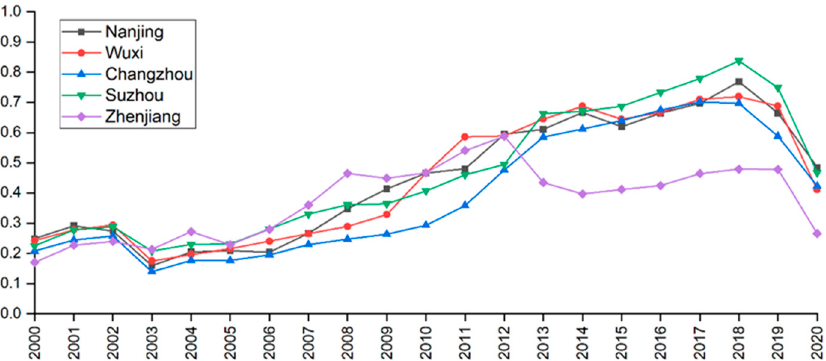
Figure 4. Comprehensive development level of the tourism economy of five cities in southern from 2000 to 2020. Jiangsu from 2000 to 2020.